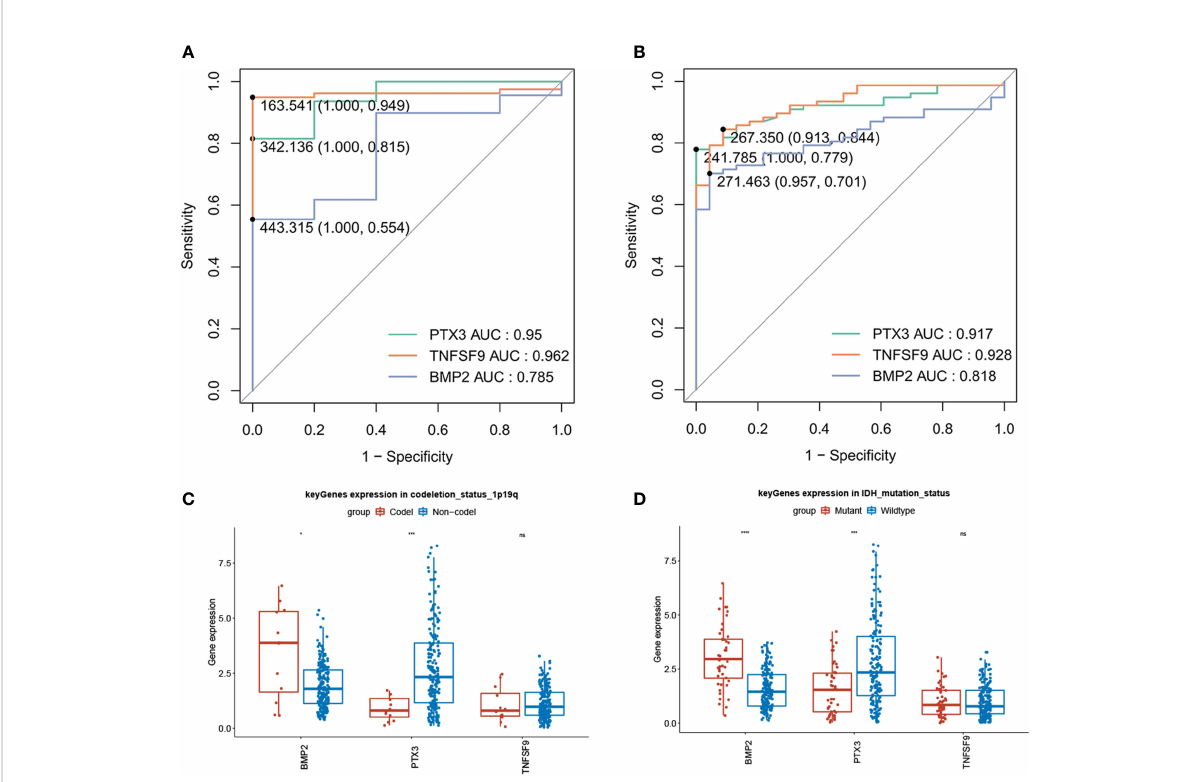
FIGURE 9 Diagnostic value of model genes (AUC >0.7) and signi fi cant differences in gene BMP2 and PTX3 between 1p/19q codeletion and IDH mutation ( P < 0.05). (A) Single-gene ROC curve for the three model genes in TCGA dataset. (B) Single-gene ROC curve for the three model genes in the GSE4290 dataset. (C) Compared with 1p/19q non-codeletion, BMP2 was high expression in 1p/19q codeletion, while PTX3 was low expression. (D) In contrast with the IDH wild type, BMP2 showed a strong expression in IDH mutation, while PTX3 showed a weak